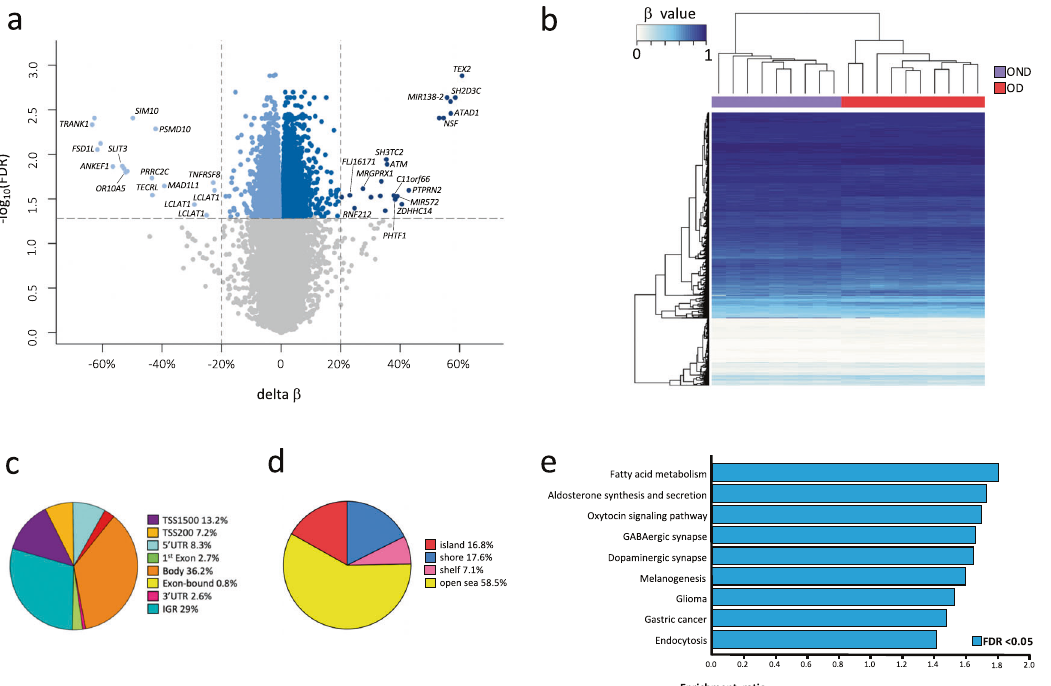
Fig. 1 Comparison of visceral adipose tissue DNA methylation pro fi les between patients with obesity but without diabetes (OND) and patients with obesity and diabetes (OD). a Volcano plot shows differences in methylation. Points represent all analyzed CpGs, and blue points indicate DMCs (FDR < 0.05): lighter blue hypomethylated and darker blue hypermethylated in OD, and gray points non-signi fi cant. b Heat map of DMCs showing DNA methylation levels for each CpG (row) by patient (columns), after applying an unsupervised hierarchical clustering analysis. c Distribution of the DMCs among the different genomic locations. d Distributions of DMCs across the CGI, the shore (2 kb from the CGI), the shelf (2 – 4 kb from the CGI), and the open sea (the remaining genome) regions. e Gene set enrichment analysis of DMCs (Af fi nity propagation). Kyoto Encyclopedia of Genes and Genomes pathway enrichments associated with genes with DMCs. X axis: FDR (false discovery rate) value. DMCs differentially methylated CpGs, TSS1500 1500 – 200 bp upstream of the transcriptional start site (TSS), TSS200 200 bp upstream of the TSS, IGR intergenic regions, UTR untranslated region, CGI CpG